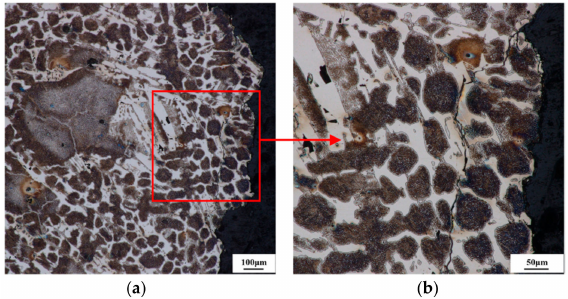
Figure 13. The crack initiated and propagated along the coarse network carbides at low ( a ) and high ( b )